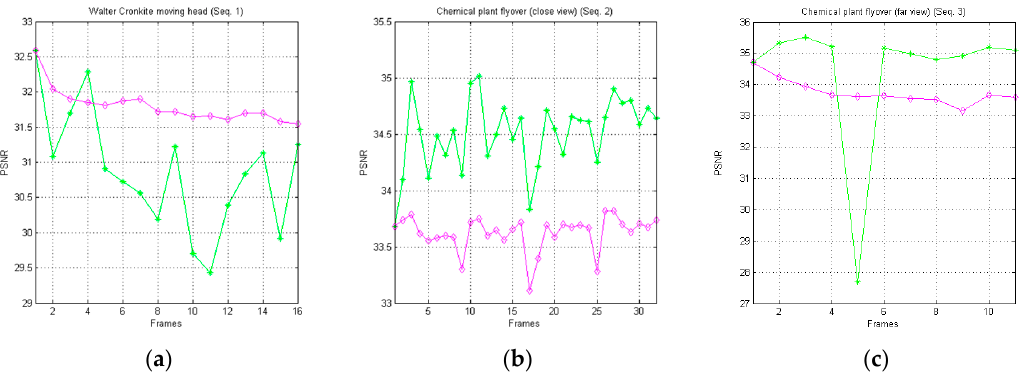
Figure 10. Graphical comparison of the achieved PSNR between the AVQ algorithm (green line) and the AVQ IS algorithm (magenta line), for ( a ) Seq. 1 ; ( b ) Seq. 2 ; and ( c ) Seq. 3 .